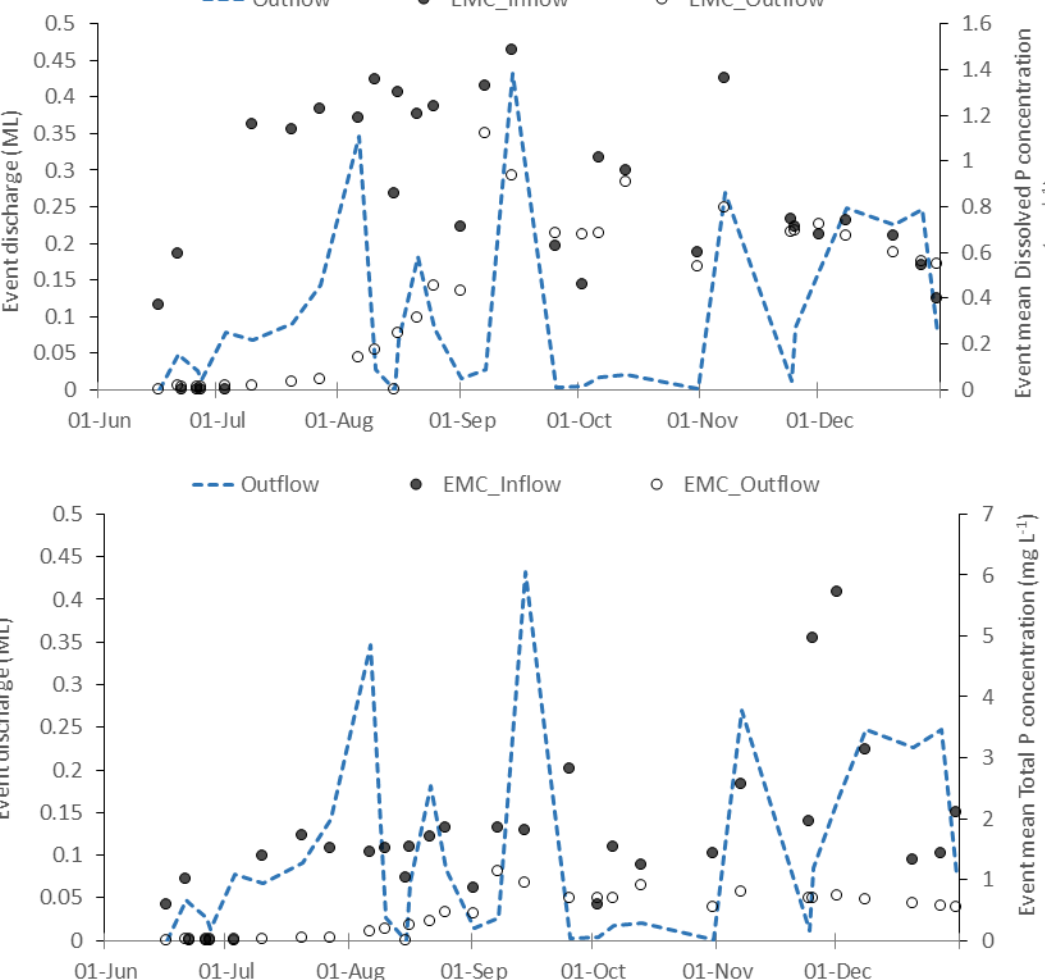
Figure 7. Discharge and event mean concentrations (EMC) of dissolved phosphorus (P) (upper figure) and total P (lower figure) for both inflow and treated outflow water from the ditch P removal structure shown in Figure 2.